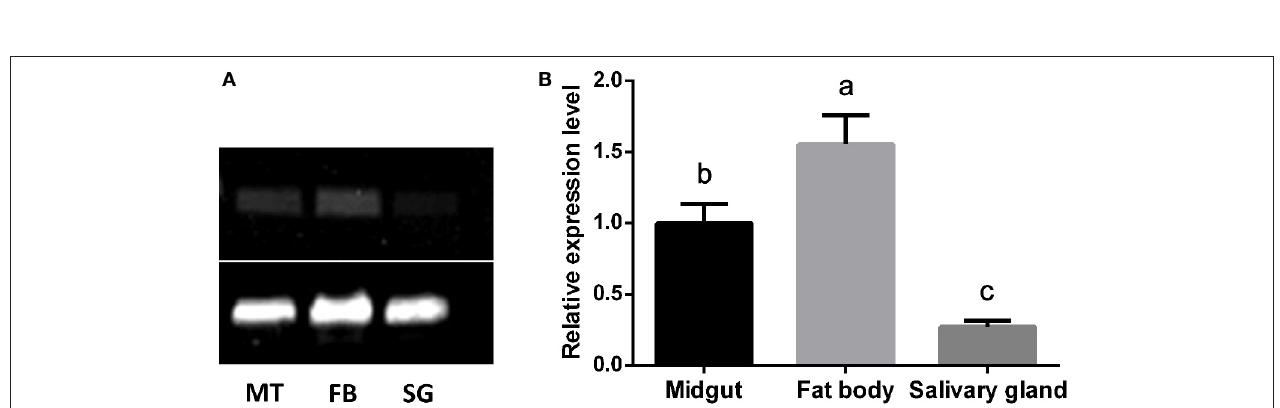
FIGURE 5 | Tissue distributions of CYP4C61 mRNA in BPH. The experiment was repeated three times with comparable results each time. Actin 1 was used as a loading control. (A) sqPCR analysis of the expression patterns of CYP4C61 in different tissues. MT, Midgut; FB, fat body; SG, silk gland. (B) Real-time qRT-PCR analysis of expression patterns of CYP4C61 in different tissues. Different letters above the bars indicate significant differences among treatments by the Tukey test: P < 0.05, lowercase letters.